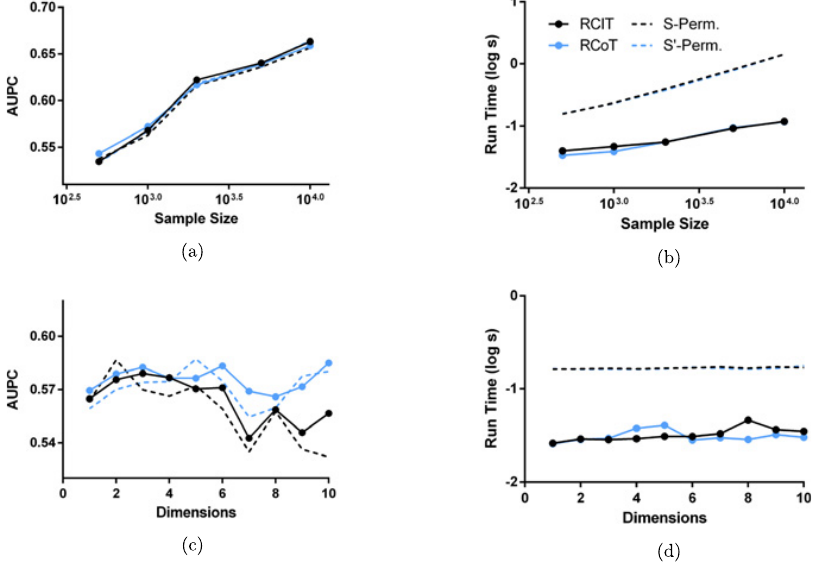
Figure 7: Results of the same AUPC experiments as in Section 7.3 except comparing RCIT and RCoT against S-Perm and S 󸀠 -Perm. Subfigures (a) and (b) again vary as a function of sample size, while subfigures (c) and (d) vary as a function of conditioning set size. RCIT and RCoT are much faster than the permutation tests but yield comparable